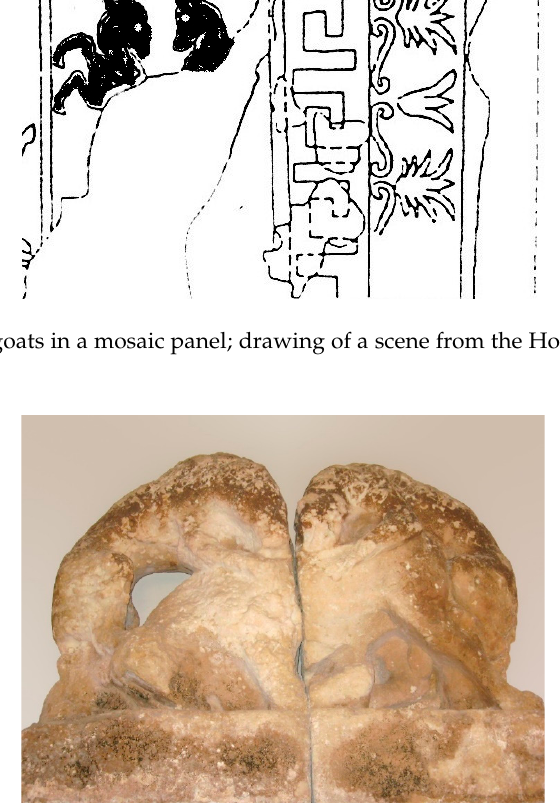
Figure 17. Two felines attacking a bull (MGW inv. no. 2520); limestone sculpture; from Selinunte, Sicily; ca. 6th century BCE .